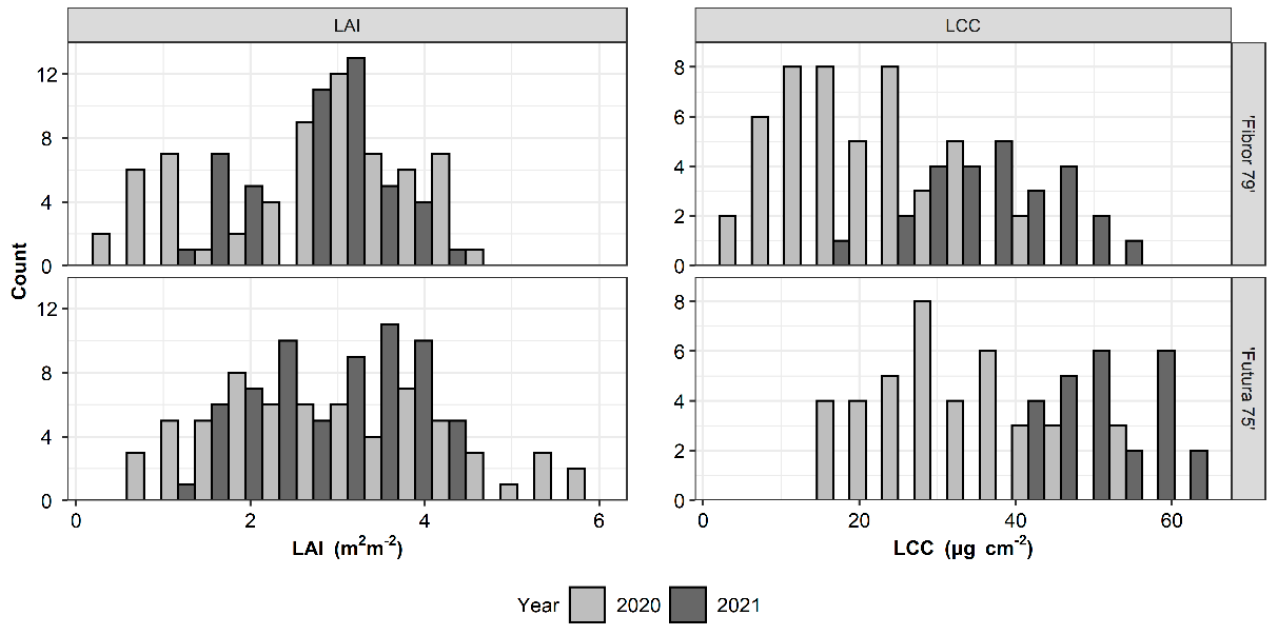
Figure 3. Distribution of two-year LAI and LCC data from two hemp cultivars.